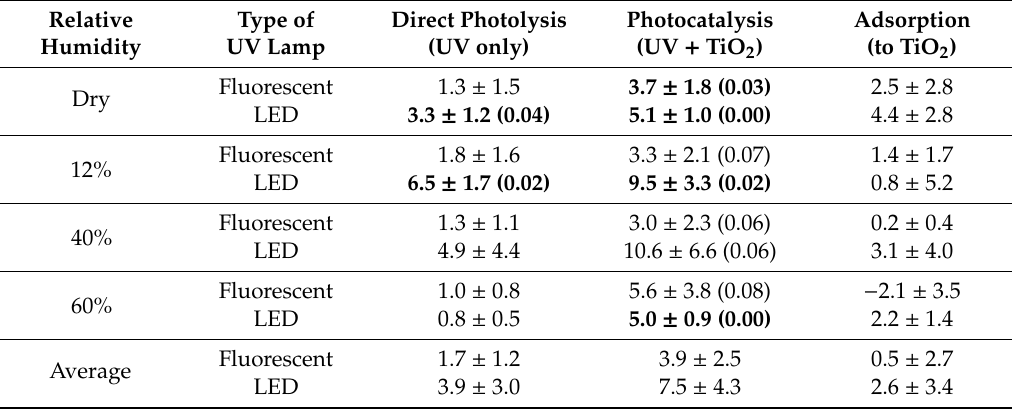
Table A7. N 2 O mitigation under di ff erent light types and relative humidity at a treatment time of 200 s. Values in the table report % reduction ± standard deviation ( p -value) and are an average between treatments of NH 3 and H 2 S standard gases. Bold font signifies statistical